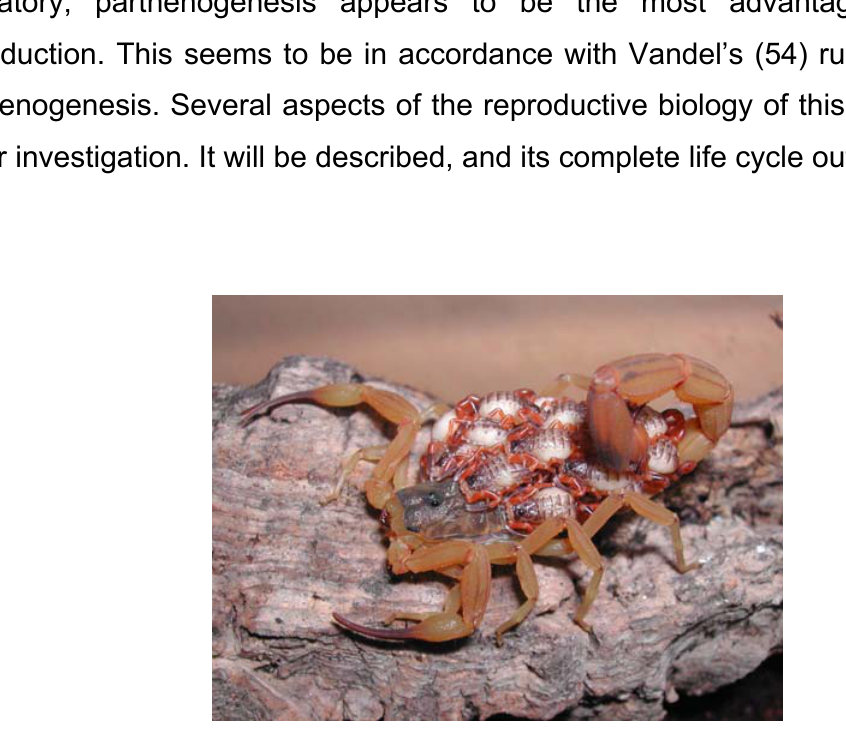
Figure 1. Parthenogenetic female of Tityus serrulatus with